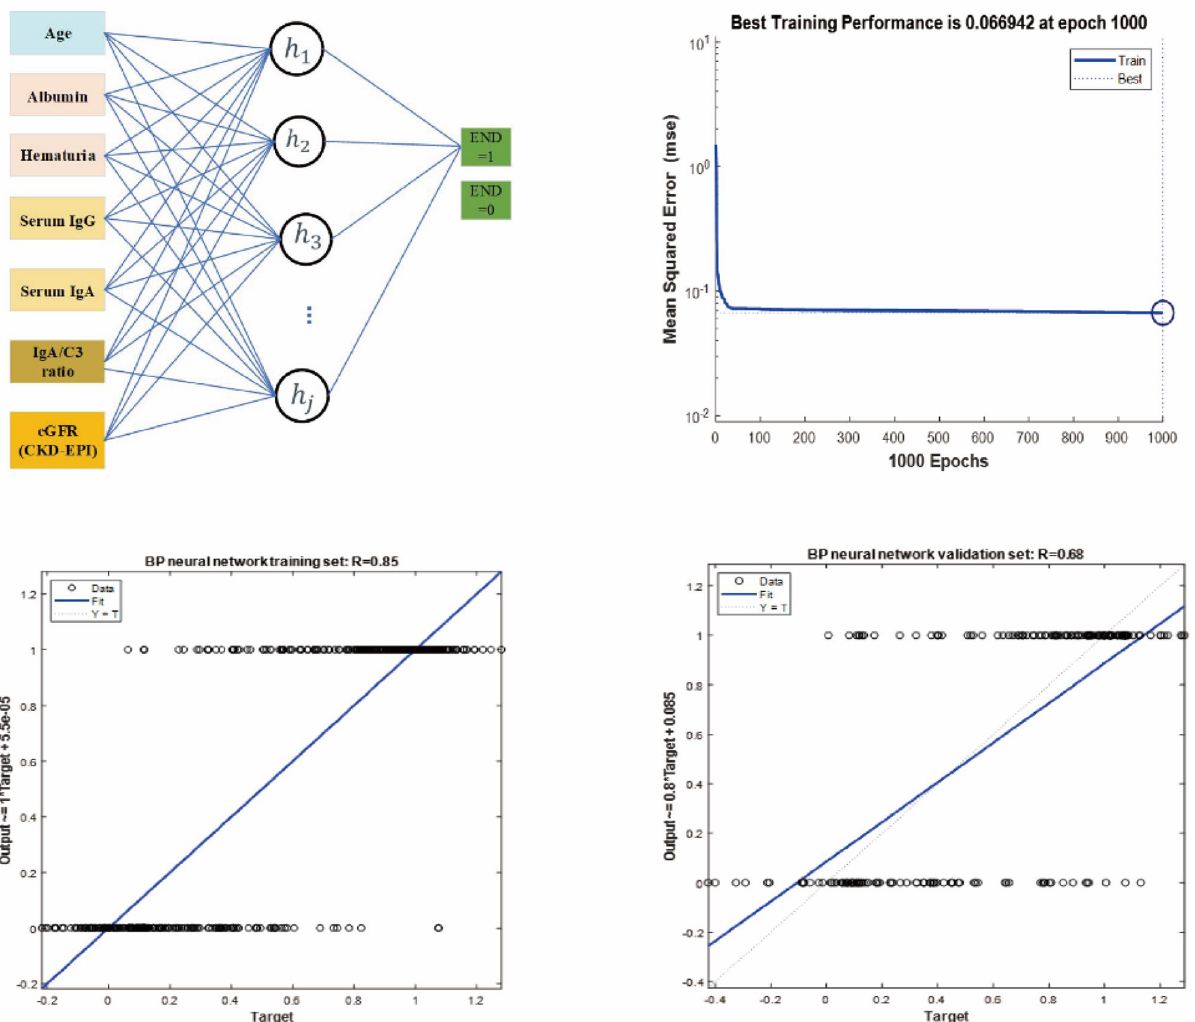
Figure 3. The structure of the artificial neural networks model and BP-ANN training